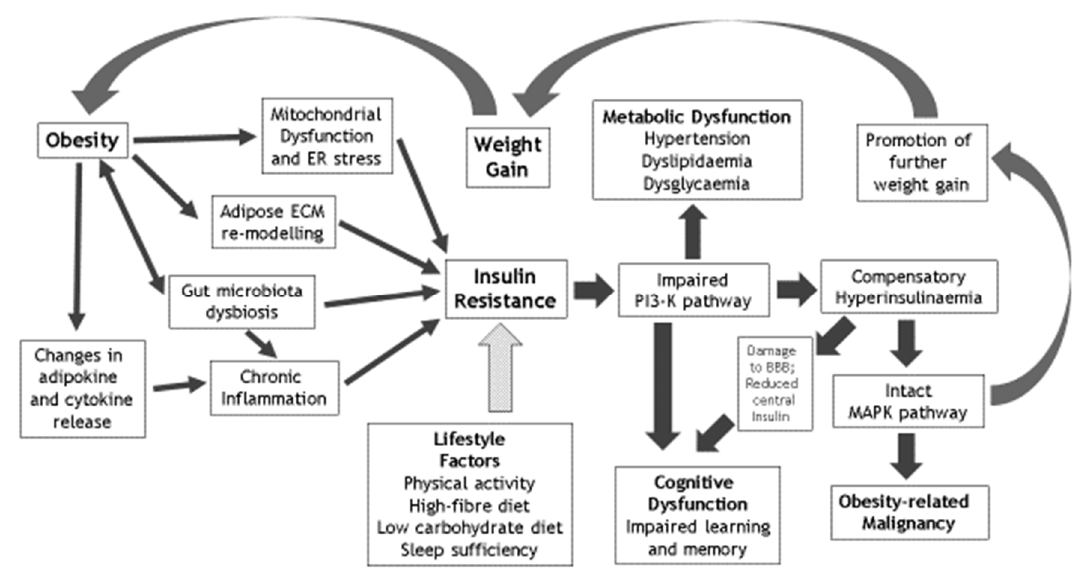
Figure 1. Overview of the mechanisms that underlie obesity-related insulin resistance (IR) and the metabolic and cognitive sequelae of IR. BBB: blood brain barrier; ECM: extracellular matrix; ER: endoplasmic reticulum; MAPK: mitogen-activated protein kinase; PI3K: phosphotidylinositol 3-kinase. Solid arrows: causative factors; speckled grey arrow: inhibitory factors.